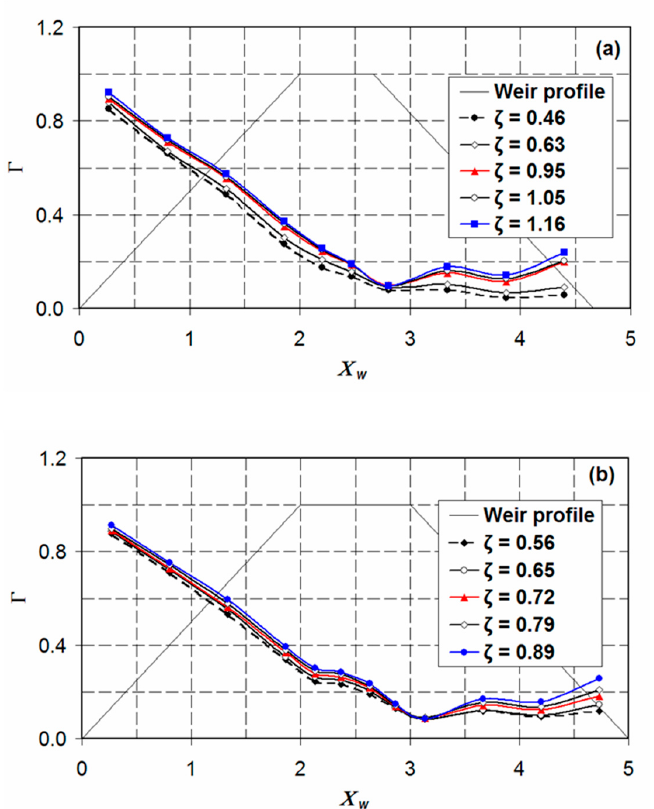
Figure 3. Variation of the normalized bed pressure Γ with the normalized horizontal distance X w for various values of relative overflow head ζ . The experimental data are from the test series ( a ) Pn10 and ( b ) Pn15.